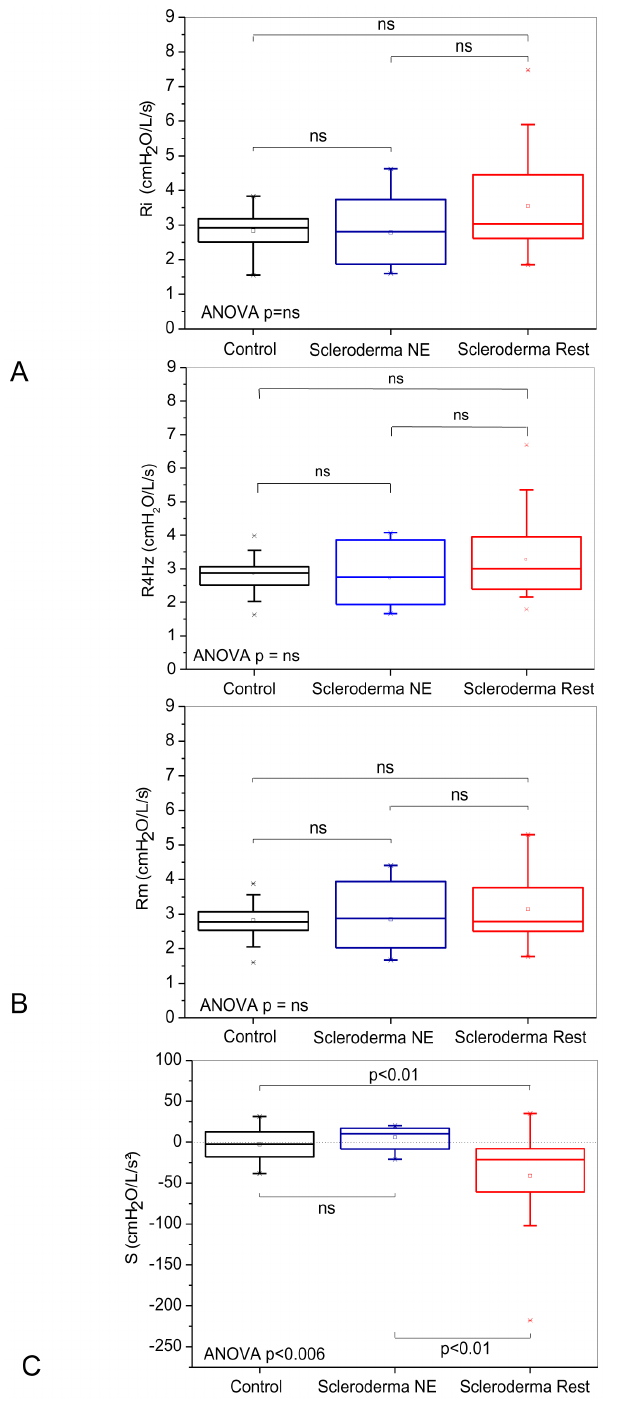
Figure 5. Effect of the restricted pattern in the lung volume tests on the resistive properties of the respiratory system. The total resistance of the respiratory system (Ri; Figure A) and the mean resistance (Rm; Figure B) did not change, whereas in (C), we observe that the restriction results in more negative S values.